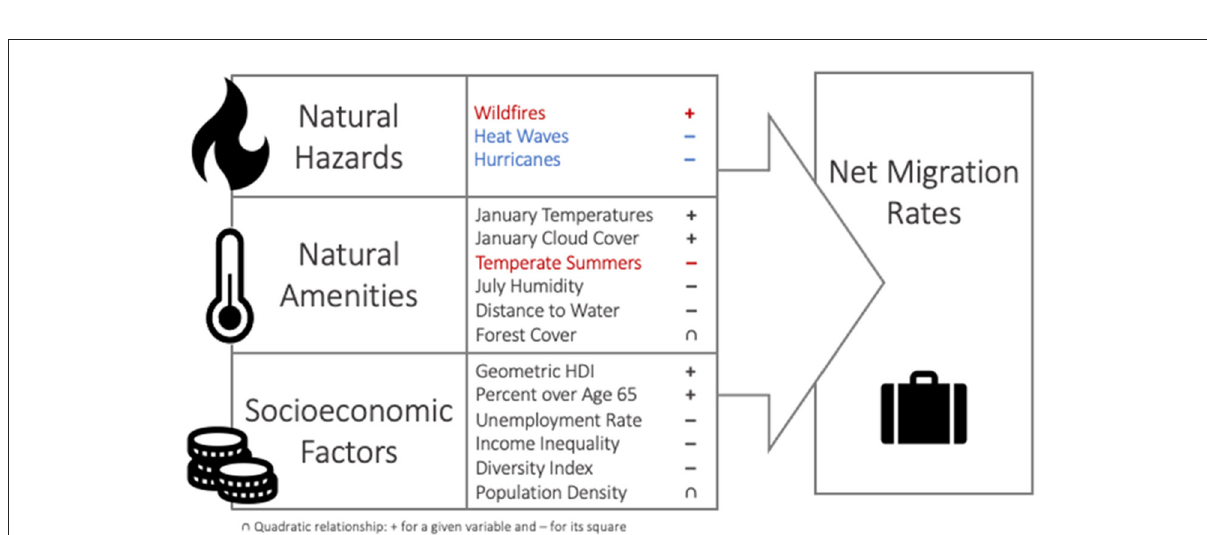
FIGURE7 Conceptual diagram highlighting significant relationships between SAR input variables and net migration rates. The most salient relationships given climate change are highlighted in red and blue. Riverine flooding, earthquakes, and topographic diversity were included but not significant. Typologies of major employment sectors and the rural-urban continuum were also included. There were significant positive relationships with manufacturing, recreation, and nonspecialized counties relative to agricultural counties. Relative to large metro counties (population over one million), there were significant negative relationships with RUCC codes designating metro and nonmetro counties of smaller population